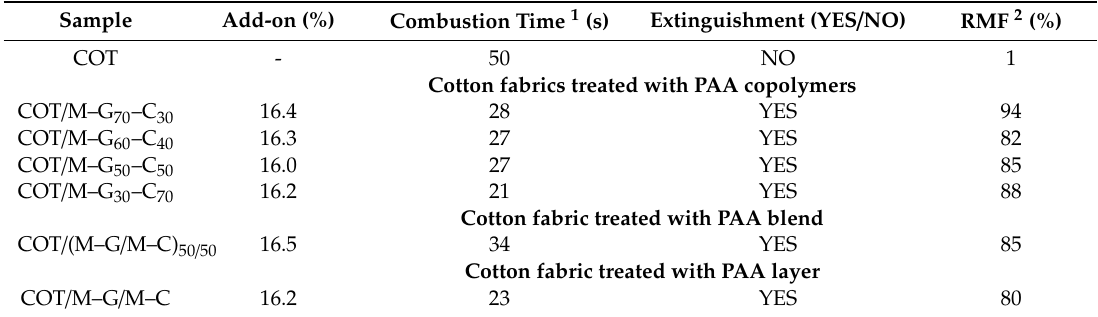
Table 6. Combustion data of untreated and PAA-treated cotton fabrics from horizontal flame spread tests. Table6. CombustiondataofuntreatedandPAA-treatedcottonfabricsfromhorizontalflamespreadtests.